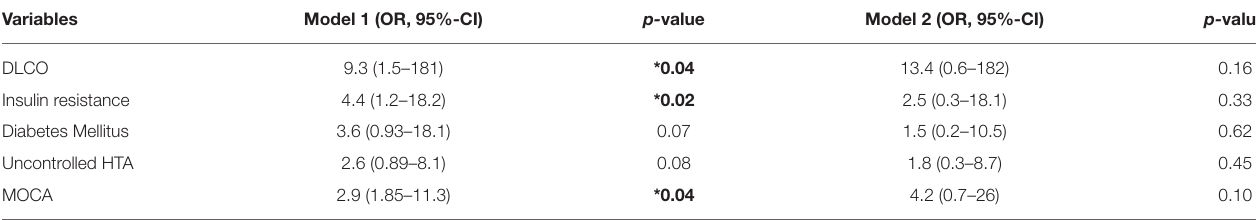
TABLE 6 | Multivariable model between OSA and risk of incident metabolic, pulmonary, and neurocognitive sequelae 1 year after COVID-19.